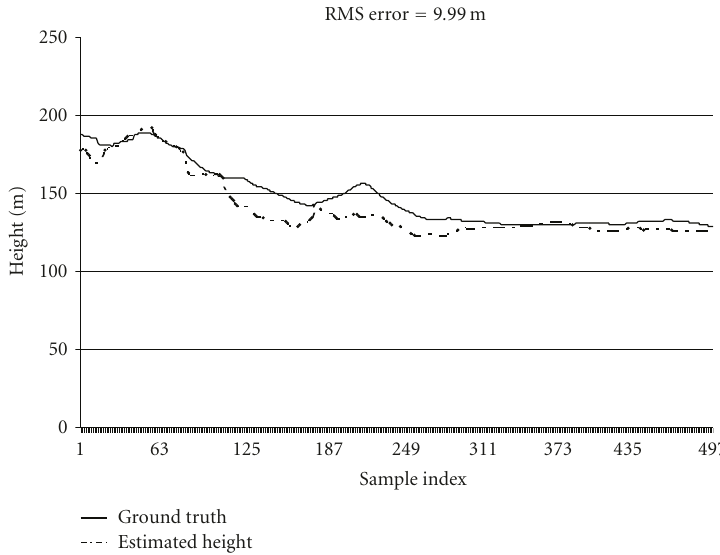
Figure 4: Height estimate from selective weighting technique (Route